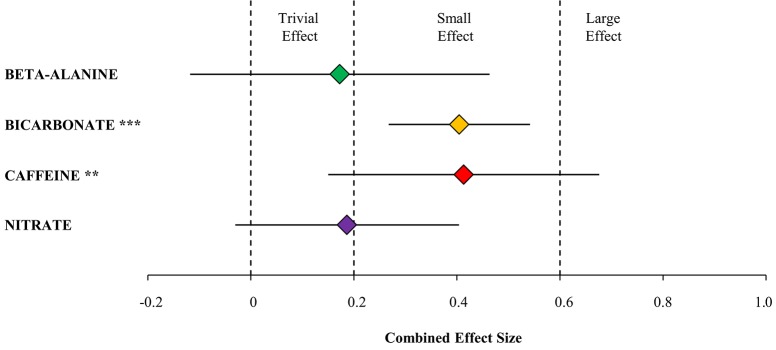
Combined effect size with 95% confidence interval displaying the impact on performance (average speed) in athletic endurance events lasting 45 s to 8 min from supplementation with either beta-alanine (7 studies) relative to pre supplementation, bicarbonate (25 studies), caffeine (9 studies) or nitrate (5 studies) relative to placebo. Hatched lines display boundaries for effect sizes being trivial (<0.2), small (0.2–0.6) or large (>0.6). ***Significant effect of bicarbonate on performance (P < 0.001). **Significant effect of caffeine on performance (P < 0.01).